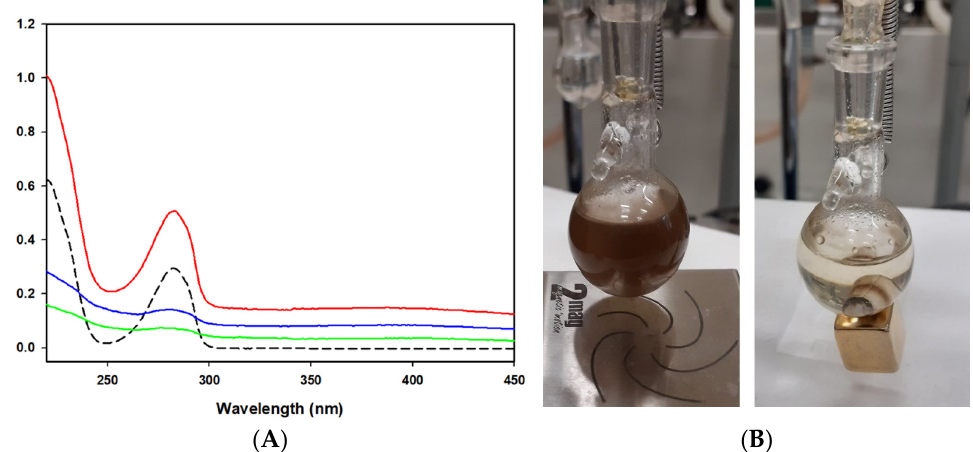
Figure 2. ( A ) UV–vis spectra of the surnatant during the washing procedure of MAG@NDGA showing the decrease in absorption due to the released NDGA after the washing cycles (1° = out of scale, not shown, 2° = red, 3° = blue, 4° = green), dashed line represents reference NDGA (0.04 mM); ( B ) dispersion of SPION under stirring with a magnetic stir bar (left) and precipitation by applying a neodymium magnet (right).